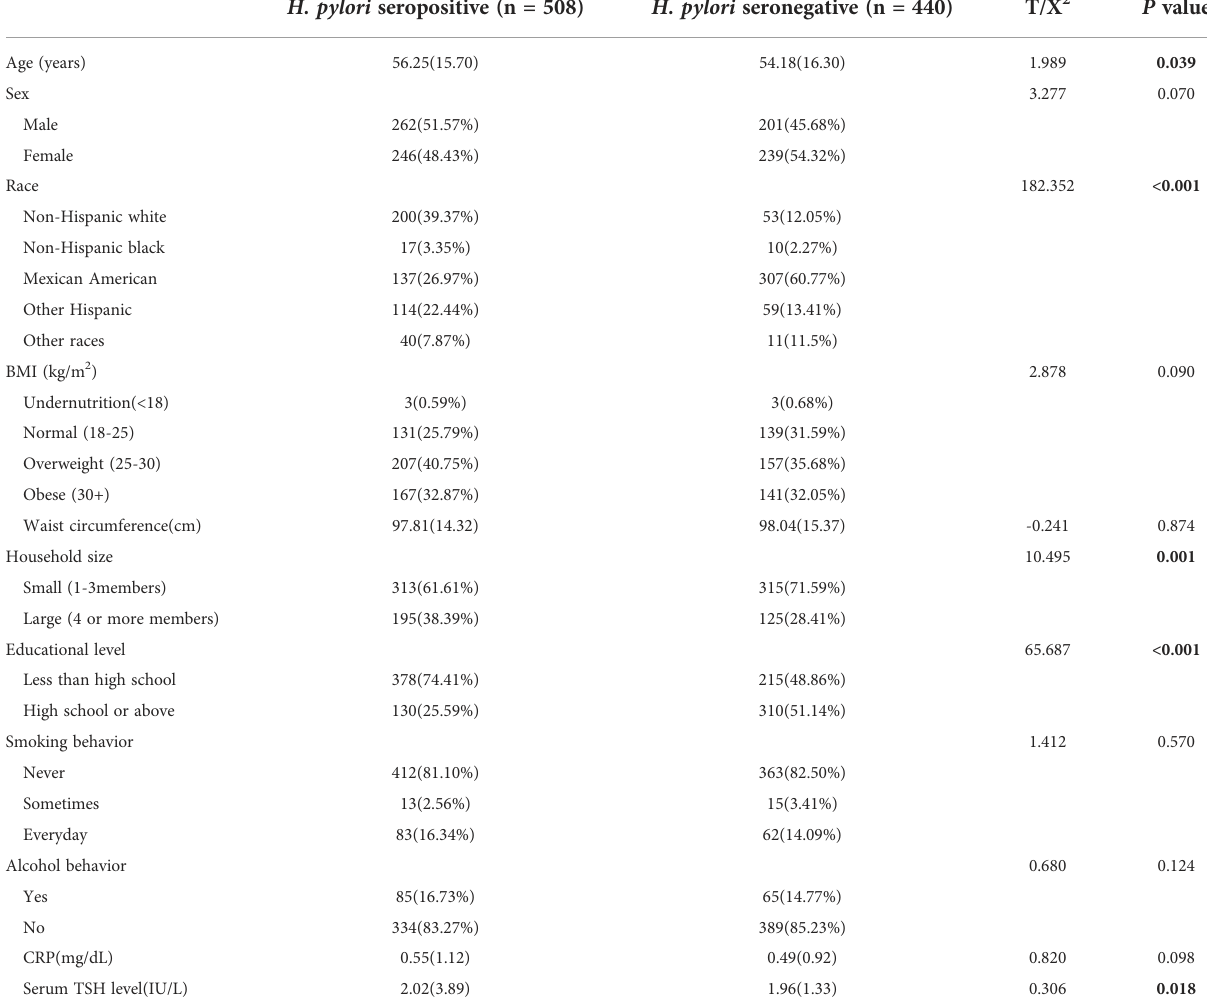
TABLE 1 Weighted characteristics of included